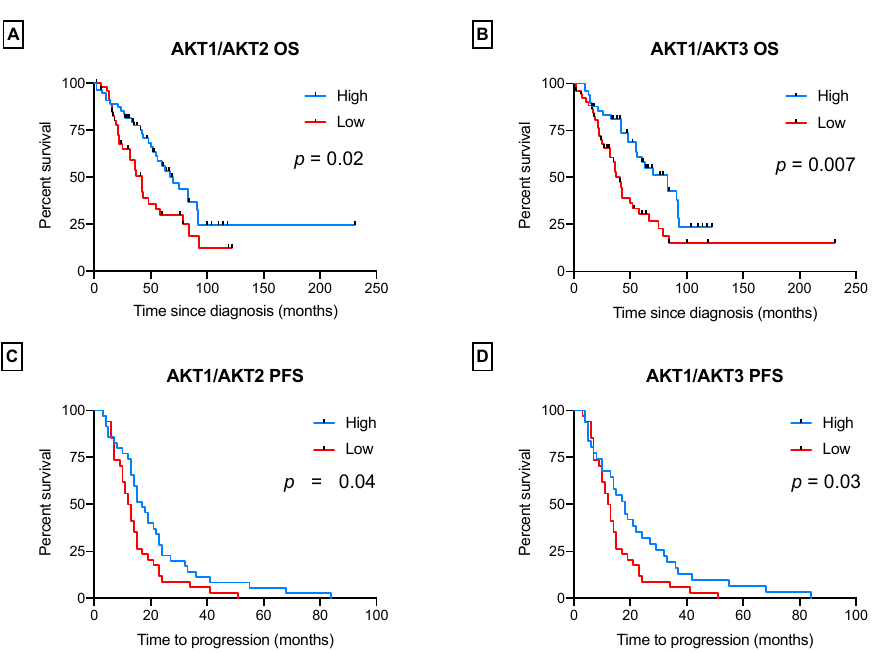
Table A1. Annealing temperature and oligonucleotide sequences used for AKT1 gene amplification on droplet digital PCR.